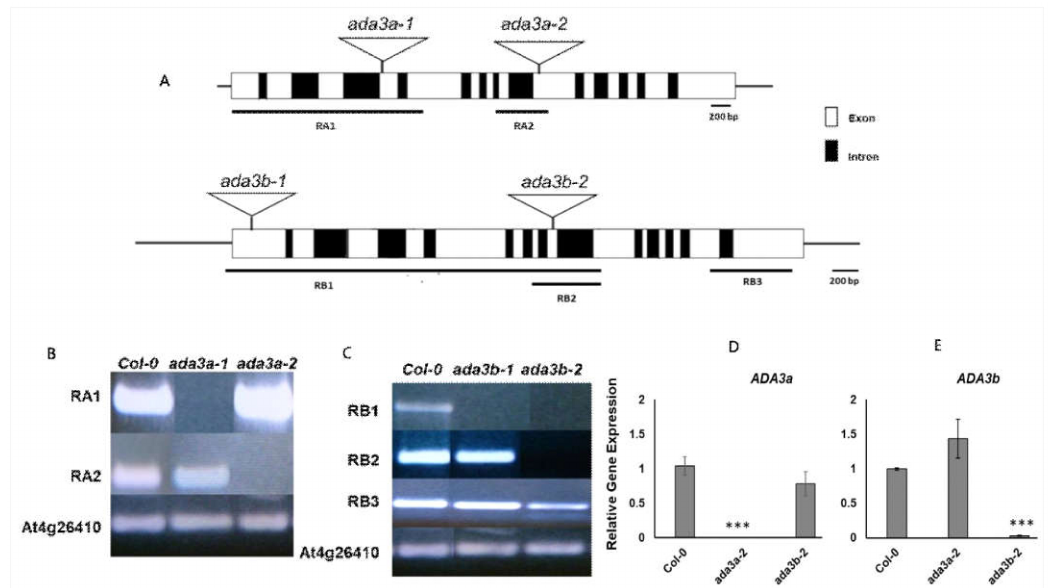
Figure 3. Schematic diagram of the Arabidopsis ADA3 genes ( A ), with ADA3a shown at the top and ADA3b shown below. Exons are denoted as white boxes, and triangular schemes indicate the position of the T-DNA insertion creating each mutant allele. The numbered horizontal bars below the ADA3a and ADA3b genes schematic refer to the coding sequence assayed in ( B ) and ( C ). Reverse-transcriptase (RT)-PCR of ADA3a and ADA3b transcripts ( B , C ). Plant genotypes are indicated at the top of each column, and the amplified fragments of the ADA3a transcript ( B ) or ADA3b transcript ( C ) are shown to the left of each row. RT-PCR of At4g26410 were used as controls for cDNA amount and quality. Real-time RT-qPCR analysis of ADA3a ( D ) and ADA3b ( E ) transcripts in wild type Col-0, ada3a-2 and ada3b-2 10 days-old, soil-grown plants, under long day conditions. Statistical significance calculated by t -test, *** p <